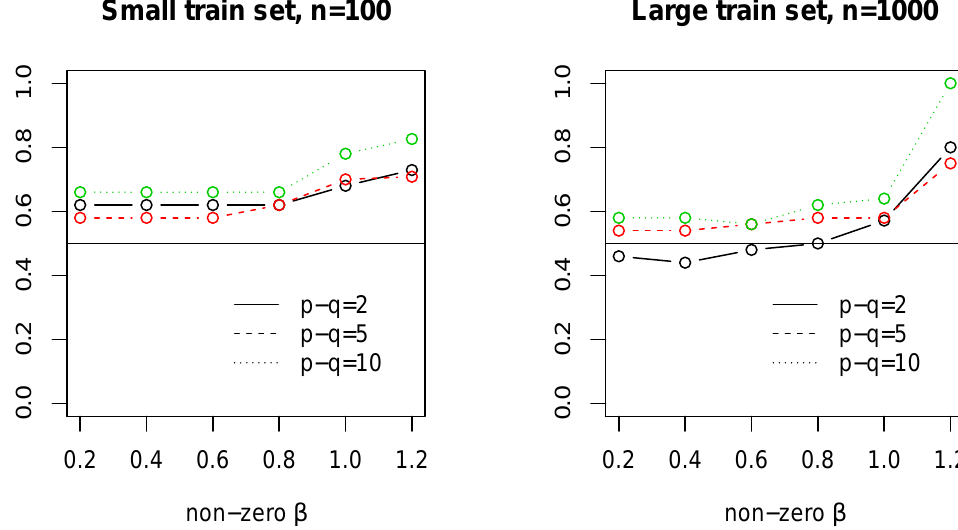
Figure 2. Probability that model with λ min outperforms model with λ 1 se for